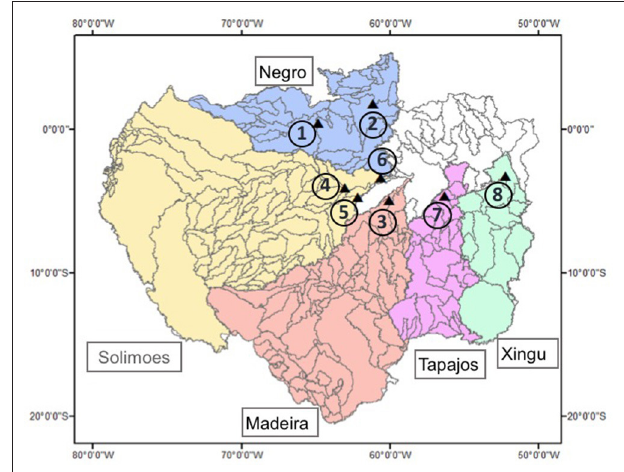
FIGURE 1 | Amazon watershed with sub catchments. Black dots refer to location of gauge stations from where we used river discharge records in this